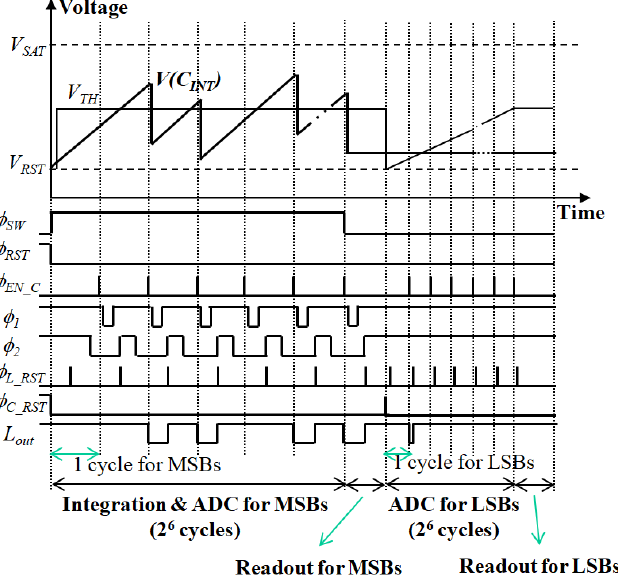
Figure 3. Timing diagram of the proposed ADC shown in Figure 2.